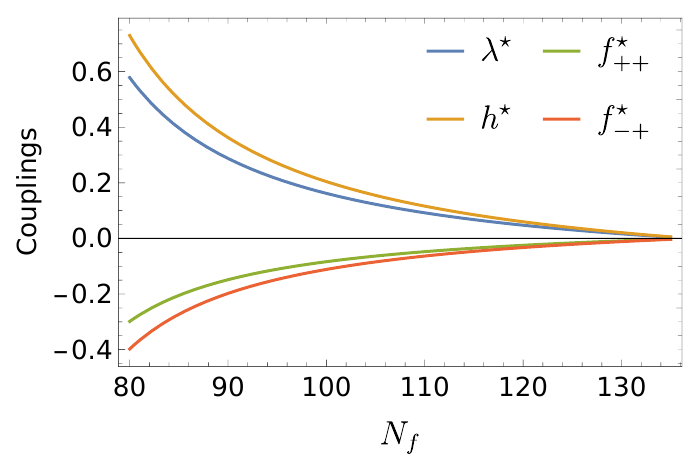
; f ? ] and p 2 = [ (cid:21) ? ; h ? ; f ? ] + ++ + (cid:0) +